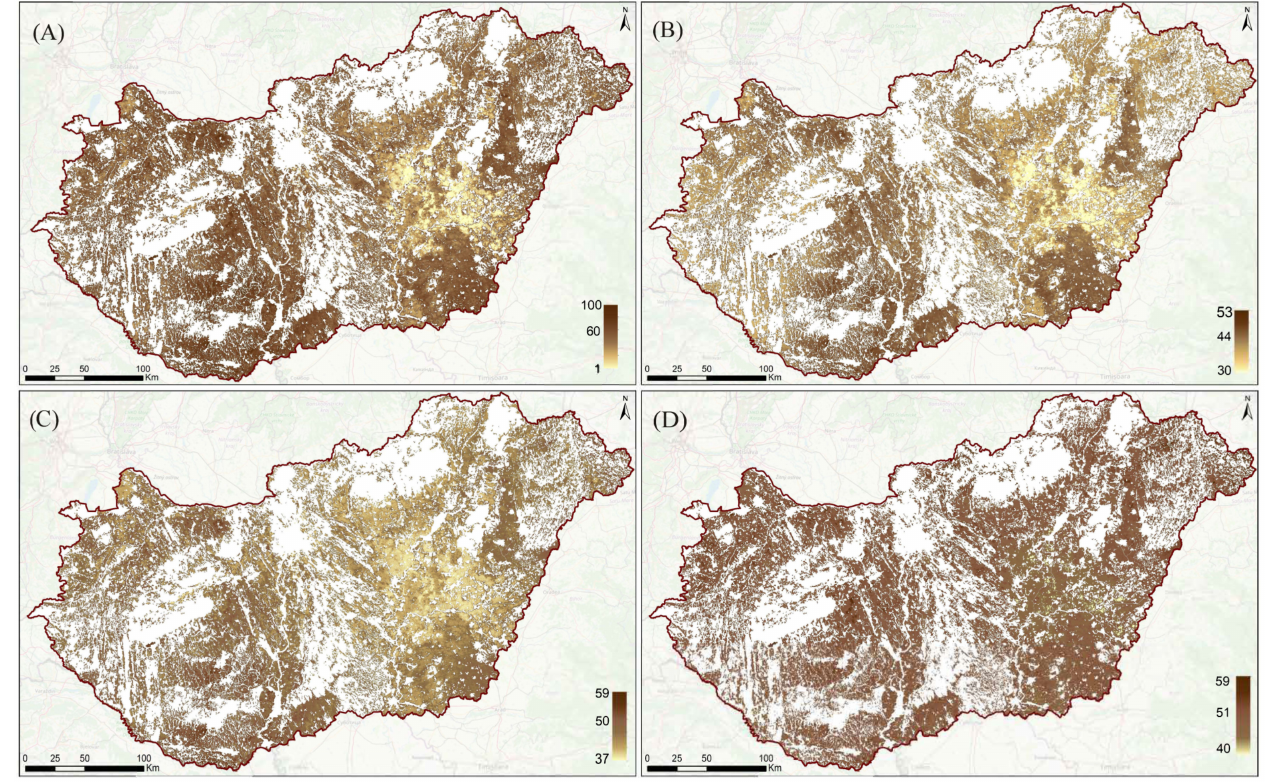
Figure 4. Croplands’ land evaluation values range between 0 and 100 in the case of general biomass productivity of arable lands without slope correction coefficients ( A ) and separately wheat ( B ), maize ( C ) and sunflowers ( D